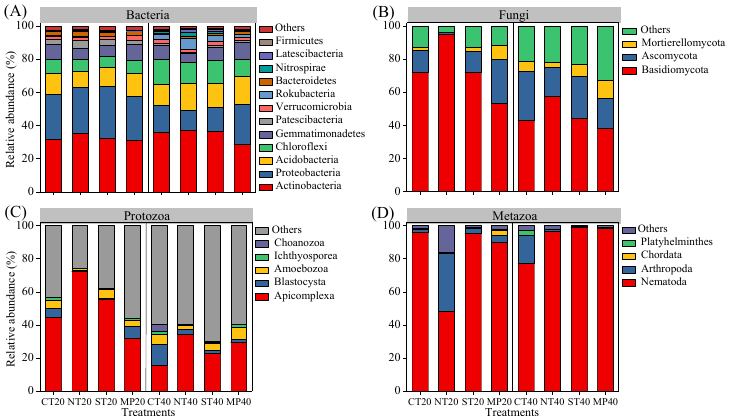
Figure 1. Soil microbial and faunal community structure under different tillage management treat- ments at two soil depths. The stacked bar graph represents the relative abundance of the major phylum. ( A ) Bacteria, ( B ) Fungi, ( C ) Protozoa, and ( D ) Metazoa. CT20, Rotary and ridge tillage at 0–20 cm depth; NT20, No-tillage at 0–20 cm depth; ST20, Subsoil tillage at 0–20 cm depth; MP20, Moldboard plowing tillage at 0–20 cm depth; CT40, Rotary and ridge tillage at 20–40 cm depth; NT40, No-tillage at 20–40 cm depth; ST40, Sub–soiling tillage at 20–40 cm depth; MP40, Moldboard plowing tillage at 20–40 cm depth. n = 24 (four treatments, three replications per treatment, and two soil depths).